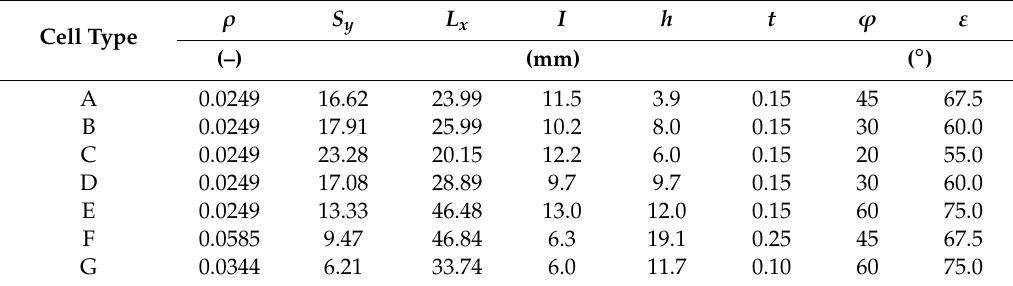
Table 2. Dimensions of cells used for research, where: ρ —cell relative density, S y —cell width, L x —cell angle, ε —angle of the bisector of the angle between the cell walls (Figure